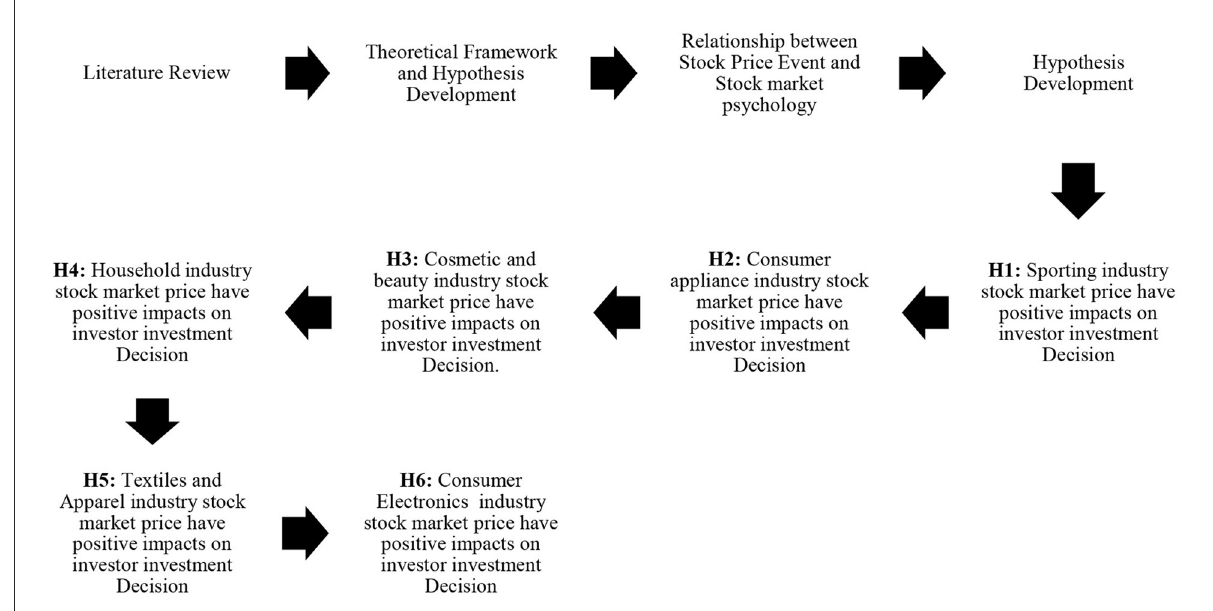
FIGURE1 Graphical representation of literature review. Source: Author.